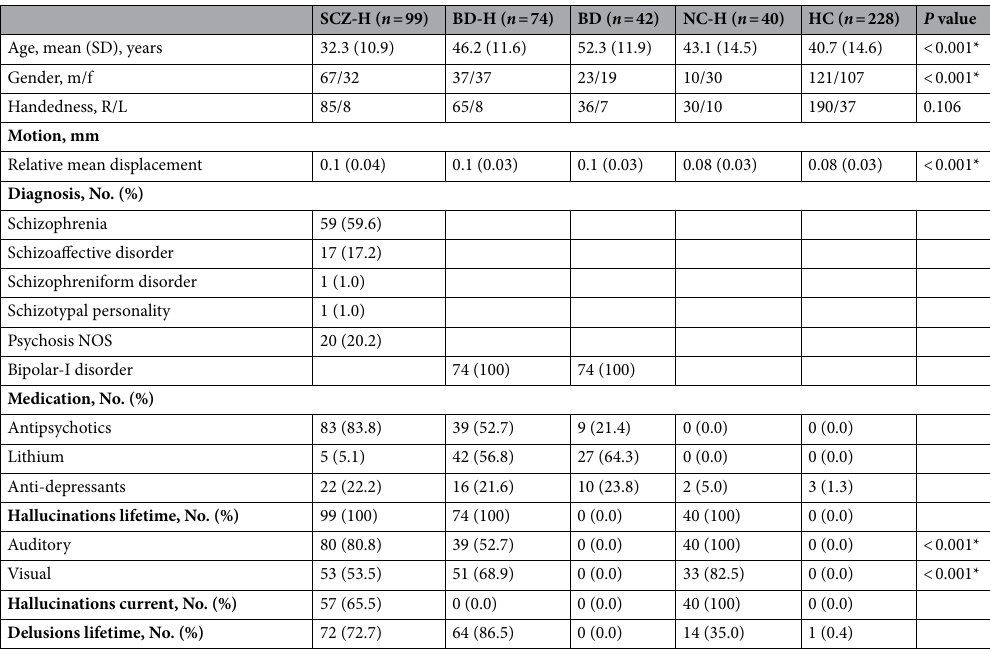
Table 1. Participant characteristics on demographic and clinical variables (n = 483). Differences between continuous variables were tested with a one-way ANOVA, and differences in dichotomous variables with Chi- square tests. Significance was set at P < 0.05. Significant differences are indicated by an asterisk (*). Current hallucinations means experiences in the last month. The current hallucinations in the SCZ-H were based on the P3 > 2 PANSS, and in NC-H with the frequency item of the PSYRATS. Number of cases with missing data: Diagnosis n = 1 SCZ-H; Antipsychotics n = 10 HC; n = 5 SCZ-H; n = 3 BD-H; n = 1 BD. Lithium n = 10 HC; n = 14 SCZ-H. Current hallucinations: SCZ-H = 23. Lifetime delusions; n = 5 HC; n = 3 NC-H; n = 21 SCZ-H. NC-H non-clinical individuals with hallucinations, NOS not otherwise specified, BD-H bipolar-I disorder with lifetime history of hallucinations, BD bipolar-I disorder without lifetime history of hallucinations, SCZ-H schizophrenia spectrum disorder with